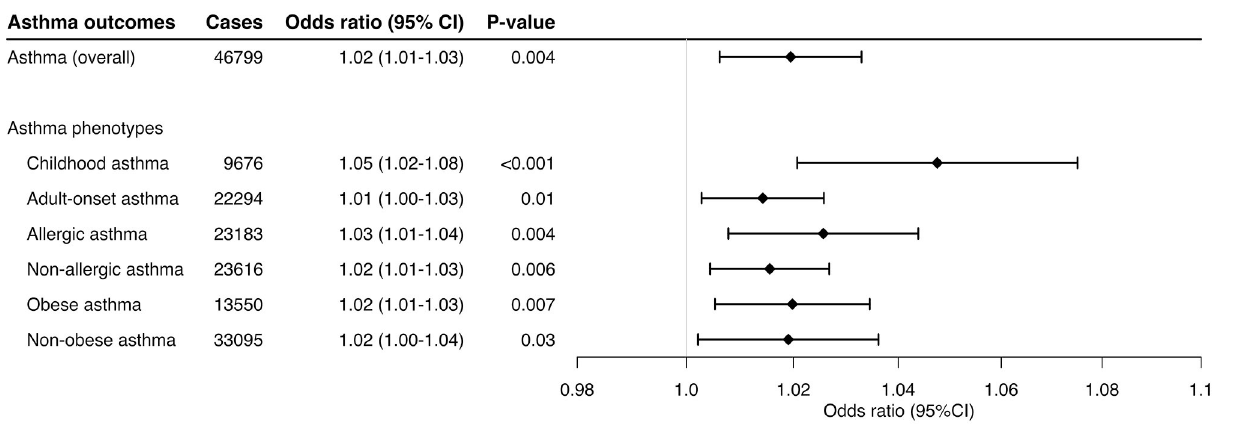
( Table 1 )—e.g., MR-Egger for childhood asthma (OR, 1.04;